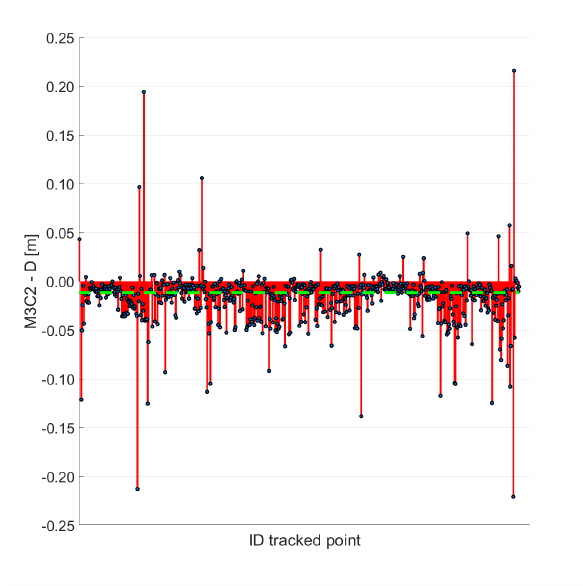
Figure 8. Difference of the M3C2 distances compared to the length of the computed motion vectors. The horizontal green line marks the median of the